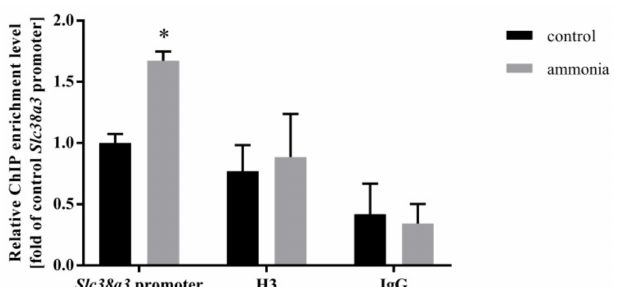
Figure 2. Nrf2 transcription factor binding to the Slc38a3 promoter region in mouse astrocytes in the absence or presence of 5 mM ammonia for 24 h. Histone H3 was used as a positive control and IgG as a negative control. Results are the mean ± SD ( n = 4). (*) p < 0.05 vs. control, two-way ANOVA, Bonferroni post hoc